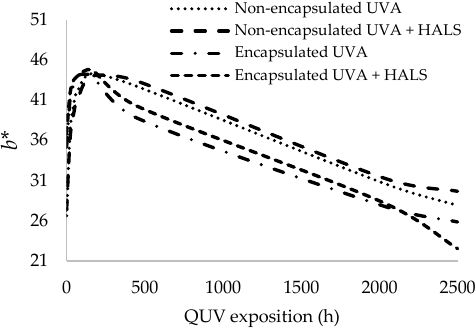
Figure 16. b * component evolution for the different formulations studied with QUV exposure.